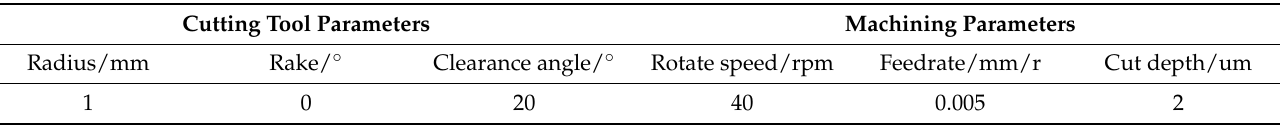
Table 4. Cutting tool parameters and machining